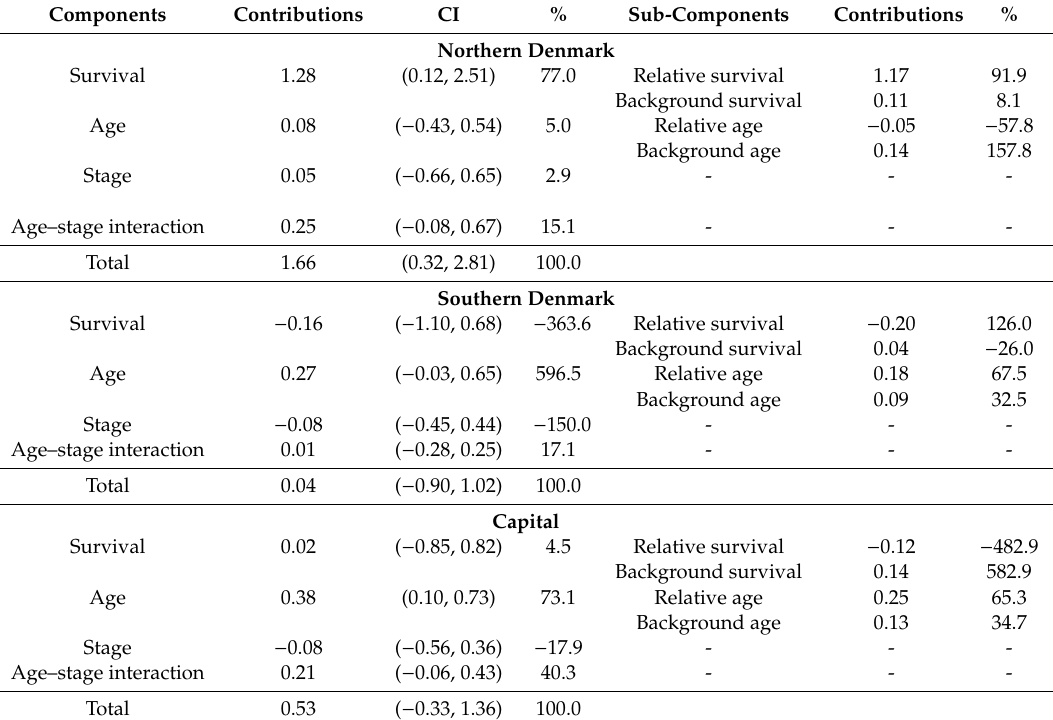
Table A1. One-year crude survival decomposition between Central Denmark and three other Danish regions, females diagnosed with breast cancer between 2008 and